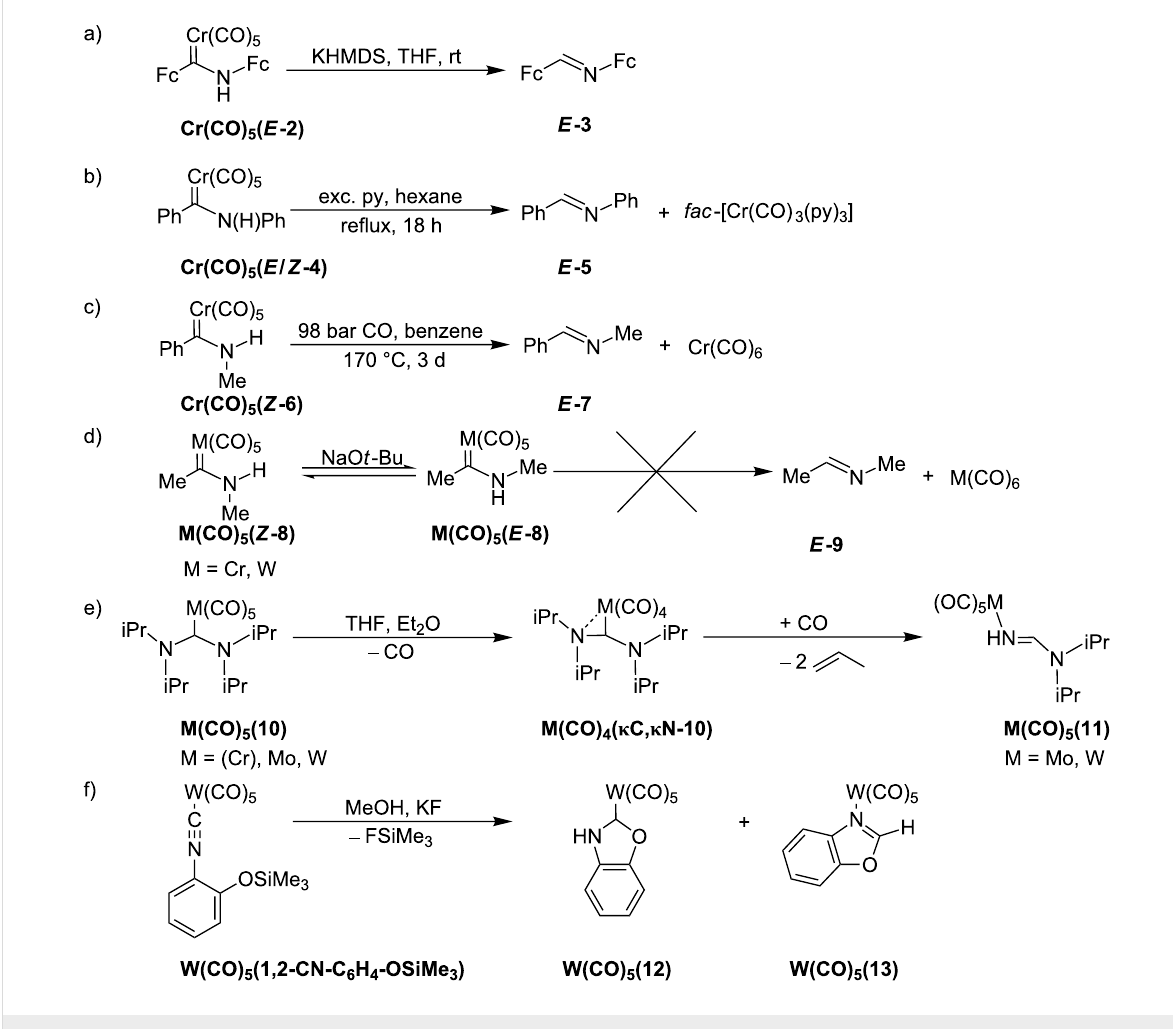
Scheme 1: Imine formation and isomerization reactions from NH carbene complexes Cr(CO) 5 ( E -2) (a) [27], Cr(CO) 5 ( E / Z -4) (b) [44], Cr(CO) 5 ( Z -6) (c) [42],